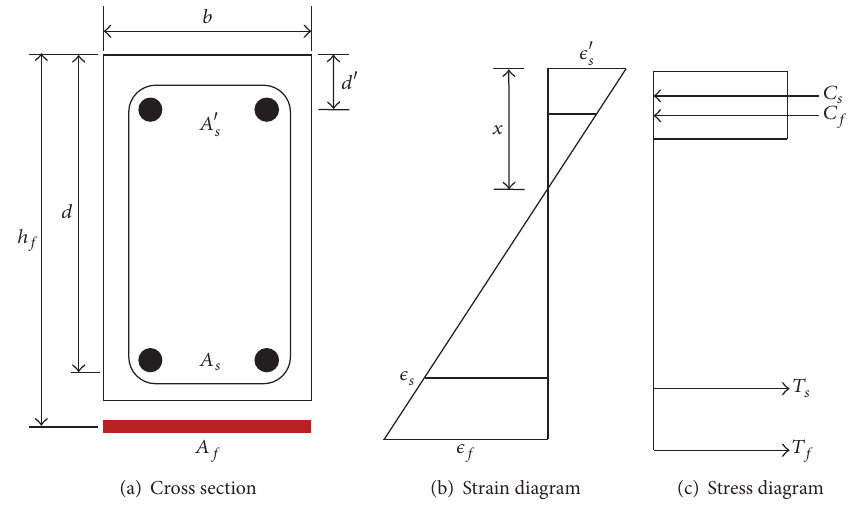
Figure 2: The cross section and stress-strain diagram of the